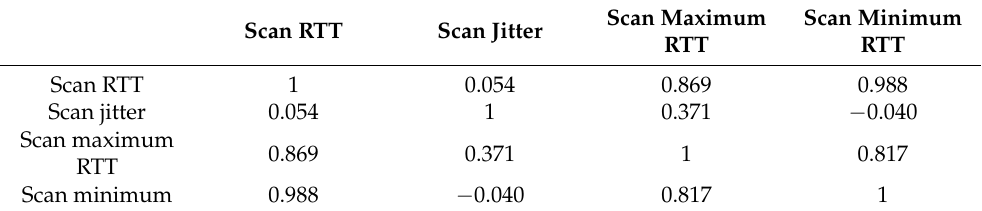
Table 5. Correlation coefficients of scan response of the training